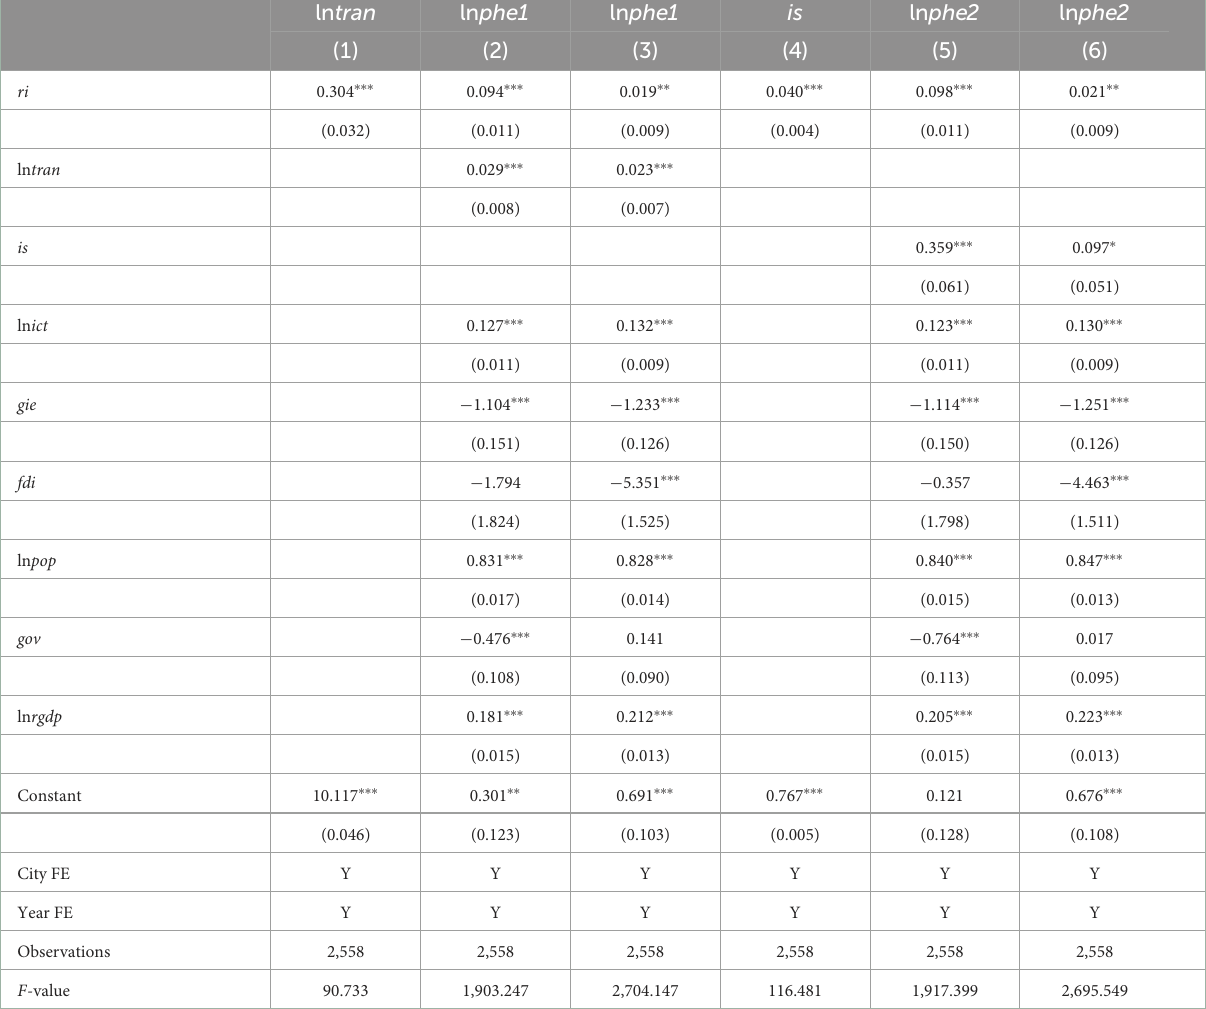
TABLE 3 Analysis of the mechanism of regional integration affecting healthcare